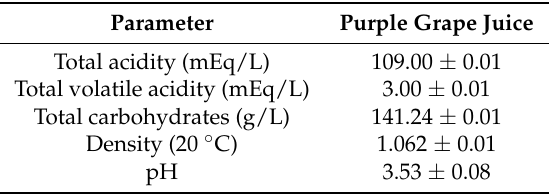
Table 1. Chemical composition of purple grape juice ( Vitis labrusca ).